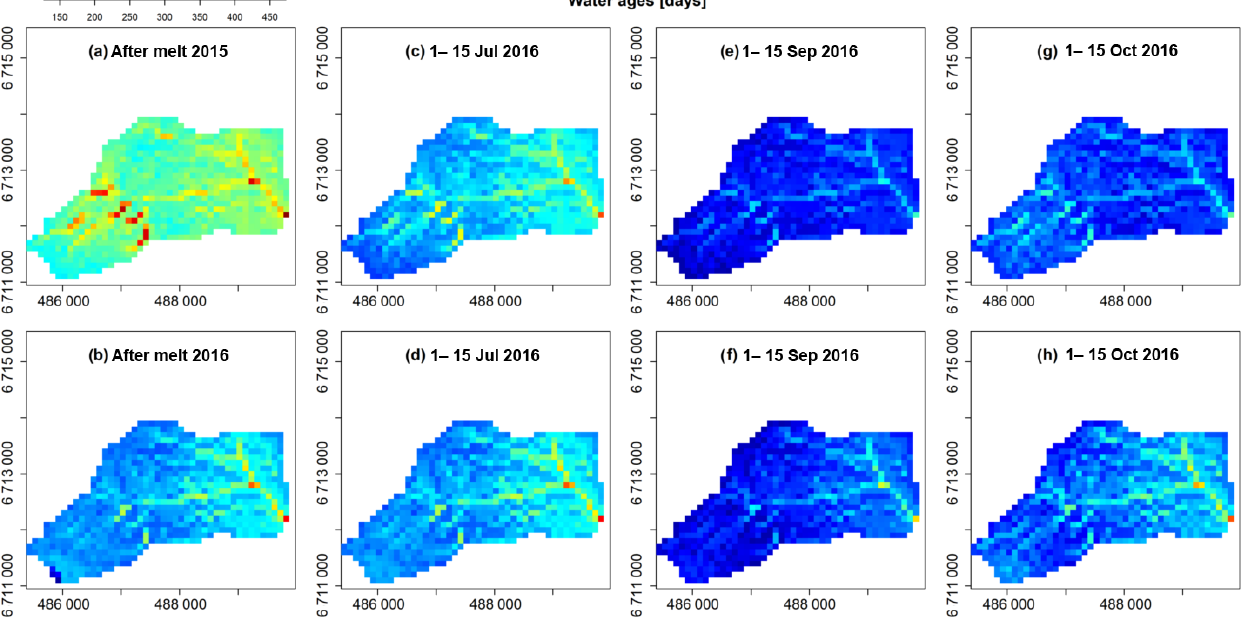
Figure 7. Spatial distribution of simulated water ages (days) of runoff contributions (overland and lateral flow) from model cells. Daily snapshots on first snow-free day in the year: (a) 28 May 2015 and (b) 18 June 2016. Values averaged over 15d: (c) 1–15 July 2015, (d) 1– 15 July 2016, (e) 1–15 September 2015, (f) 1–15 September 2016, (g) 1–15 October 2015 and (h) 1–15 October